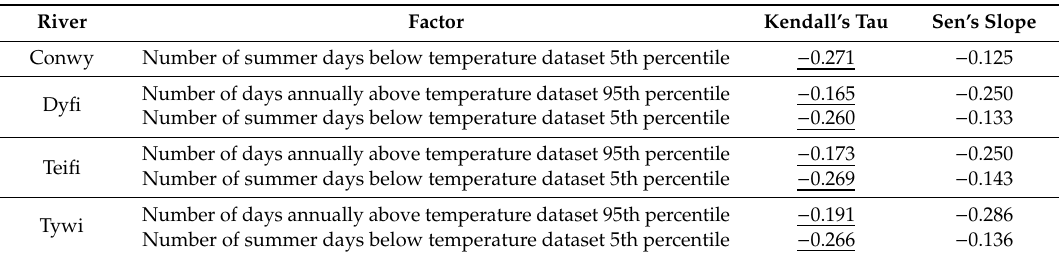
Figure 4. Number of occurrences during summer where daily average temperature is less than the 5th percentile temperature value for the full 34-year summer dataset. Linear trend for the Teifi catchment shown with red dashed line to exemplify the linear trend in all three catchments. Table 4. Statistically significant Mann-Kendall trend analysis and Sen’s slope indicator results for extreme temperature events (1982–2015) for all catchments. No significant trends were found in the Clwyd catchment. Values for Kendall’s Tau underlined are significant at p <0.05.